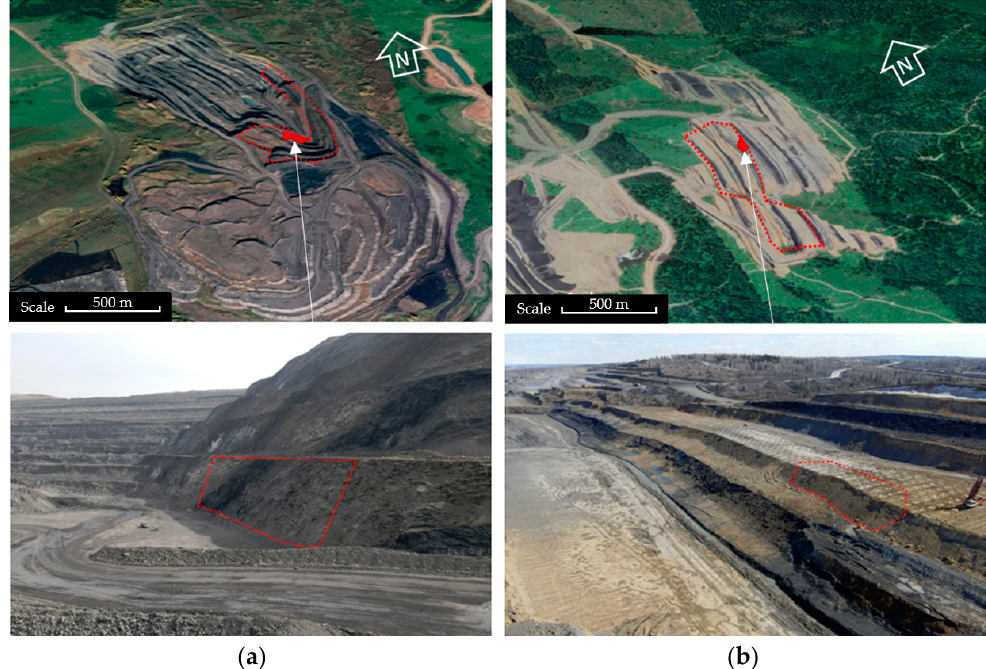
Figure 1. Studied sites of subsurface resources: ( a )—Kyrgaysky Sredniy, block No. K 67–78; ( b )—Novokazansky 2, block No. N 58–70.